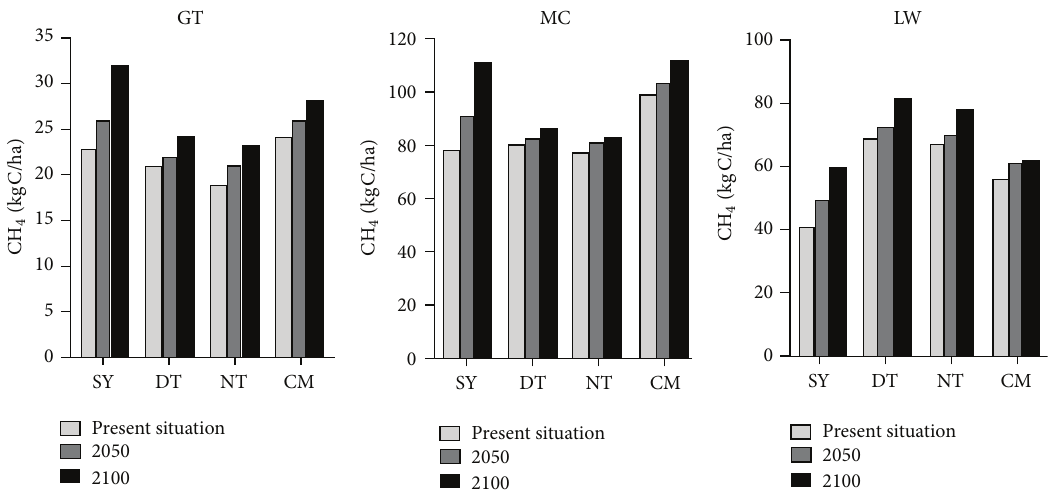
Figure 4: Comparison of present (average CH 4 emission flux of 80s and 00s) and future CH 4 emission flux of different vegetation zones at different locations.